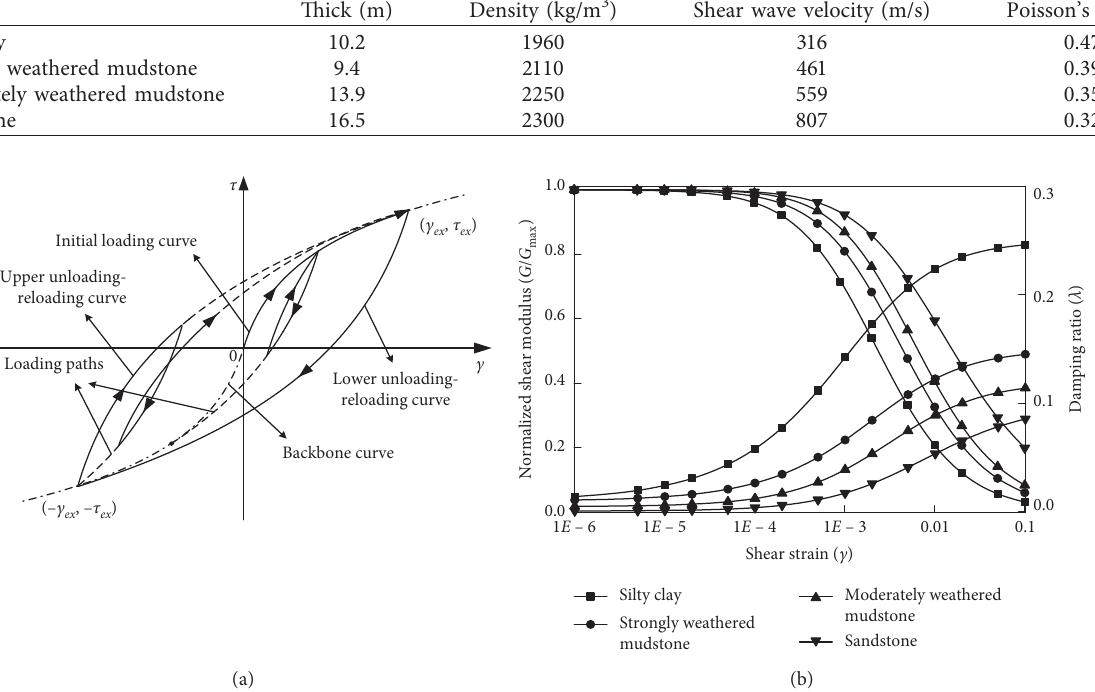
Figure 5: The stress-strain relationship of the soil and the relationship curve between G / G